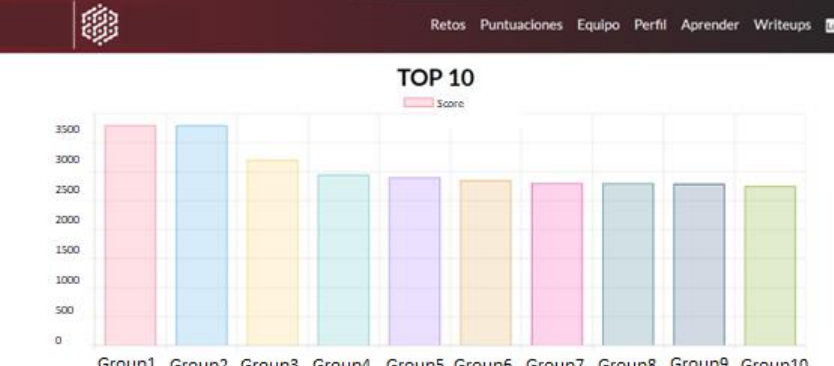
Figure 6. Dashboard of the scores section. (In this figure, the native language of the application is maintained, and when representing the interface of the application, it is considered important to maintain this characteristic).